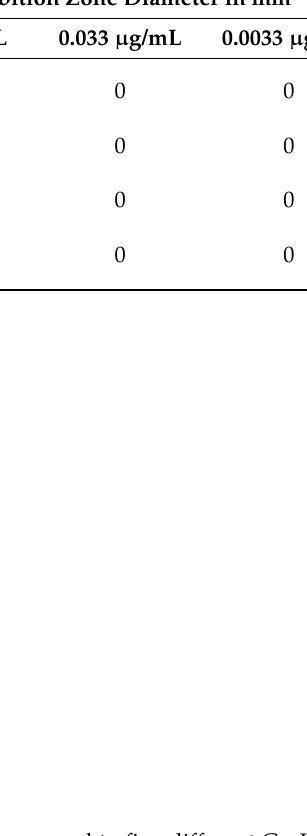
Figure 4. Inhibition of bacterial pathogens isolated from fish exposed to five different GarKS con- centrations of 33 µ g/mL (1), 3.3 µ g/mL (2), 0.33 µ g/mL (3), 0.033 µ g/mL (4) and 0.0033 µ g/mL (5). ( A ) Note inhibition of Aeromonas salmonicida strain 6421 at high concentrations of 33 µ g/mL and 3.3 µ g/mL, and no inhibition around low concentrations ≤ 0.33 µ g/mL. ( B ) Inhibition around A. hydrophila for higher concentrations of 33 µ g/mL and 3.3 µ g/mL, and no inhibition around low concentrations ≤ 0.33 µ g/mL GarKS. ( C ) Inhibition of Streptococcus agalactiae serotype Ia for high concentration of 33 µ g/mL and 3.3 µ g/mL and no inhibition on low concentrations ≤ 0.33 µ g/mL GarKS. ( D ) Inhibition of S. agalactiae serotype Ib high concentrations of 33 µ g/mL and 3.3 µ g/mL and no inhibition on low concentrations ≤ 0.33 µ g/mL